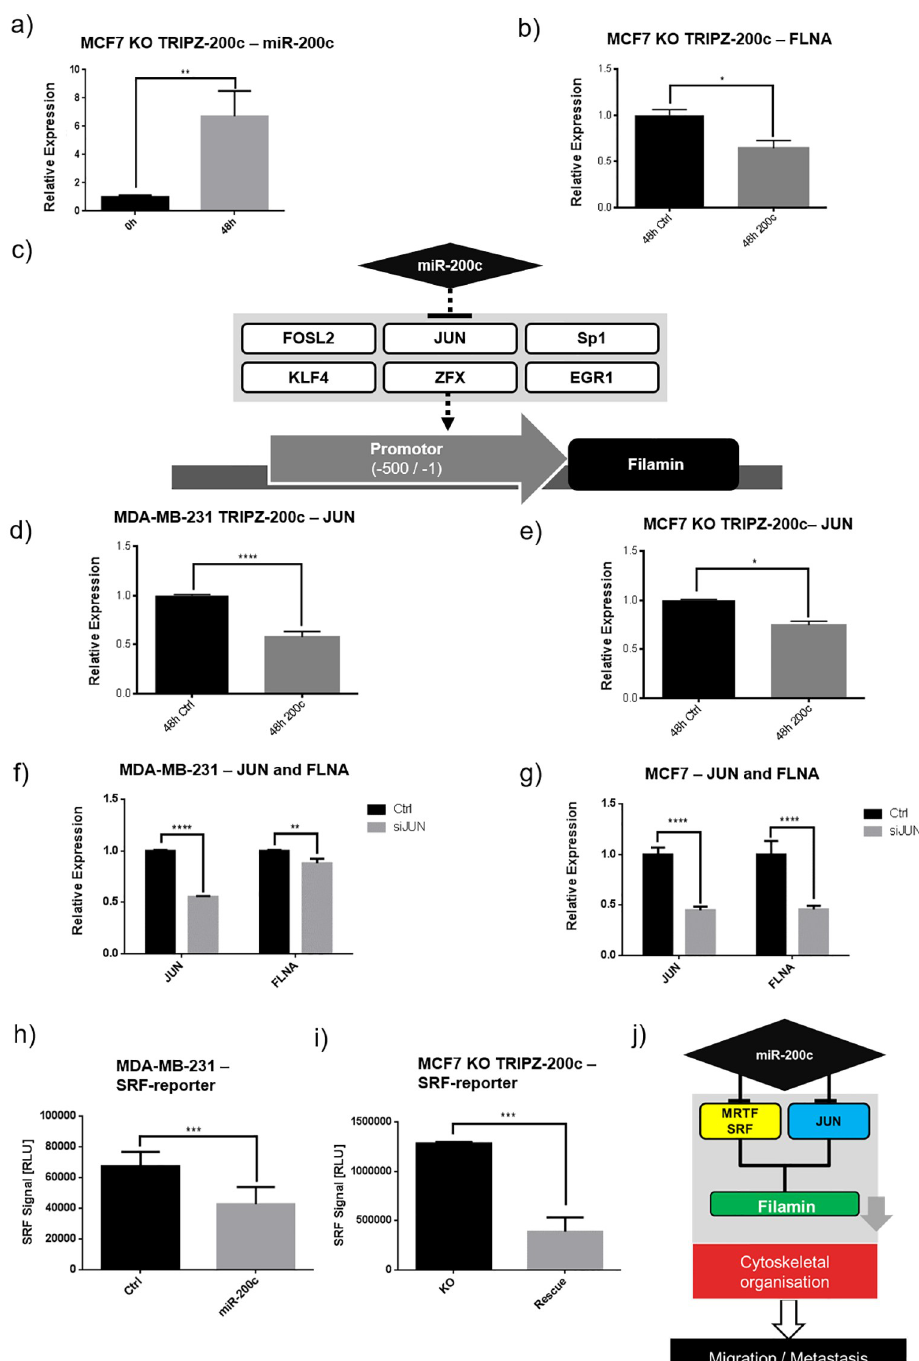
Fig 5. Filamin A is regulated by miR-200c by repression of JUN as well as SRF-MRTF. (a) After introduction of the TRIPZ-200c construct into MCF7 200c KO cells, miR-200c was re-expressed by 48 h of DOX induction and showed (b) significantly decreased FLNA expression. (c) In silico analysis of the FLNA promotor revealed 6 transcription factors which have a potential miR-200c binding site. (d) The expression of JUN was significantly decreased 48 h after induction of miR-200c in MDA-MB-231 as well as (e) re-expression in MCF7 compared to the respective TRIPZ-Ctrl cell line. (f, g) Decreased expression of FLNA was verified in MDA-MB-231 and MCF7 after transient transfection with siRNA against JUN (siJUN), compared to scrambled siRNA control (h, i) Induction of miR-200c for 48 h decreased the luciferase signal of a MRT-SRF reporter construct in MDA-MB-231 TRIPZ-200c as well as MCF7